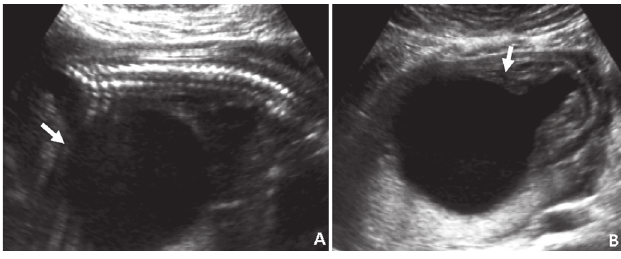
figurE 1 − 22-week ultrasound scan showing distended bladder (A) and the keyhole sign (B), suggestive of the LUTO (see white arrows) LUTO: lower urinary tract